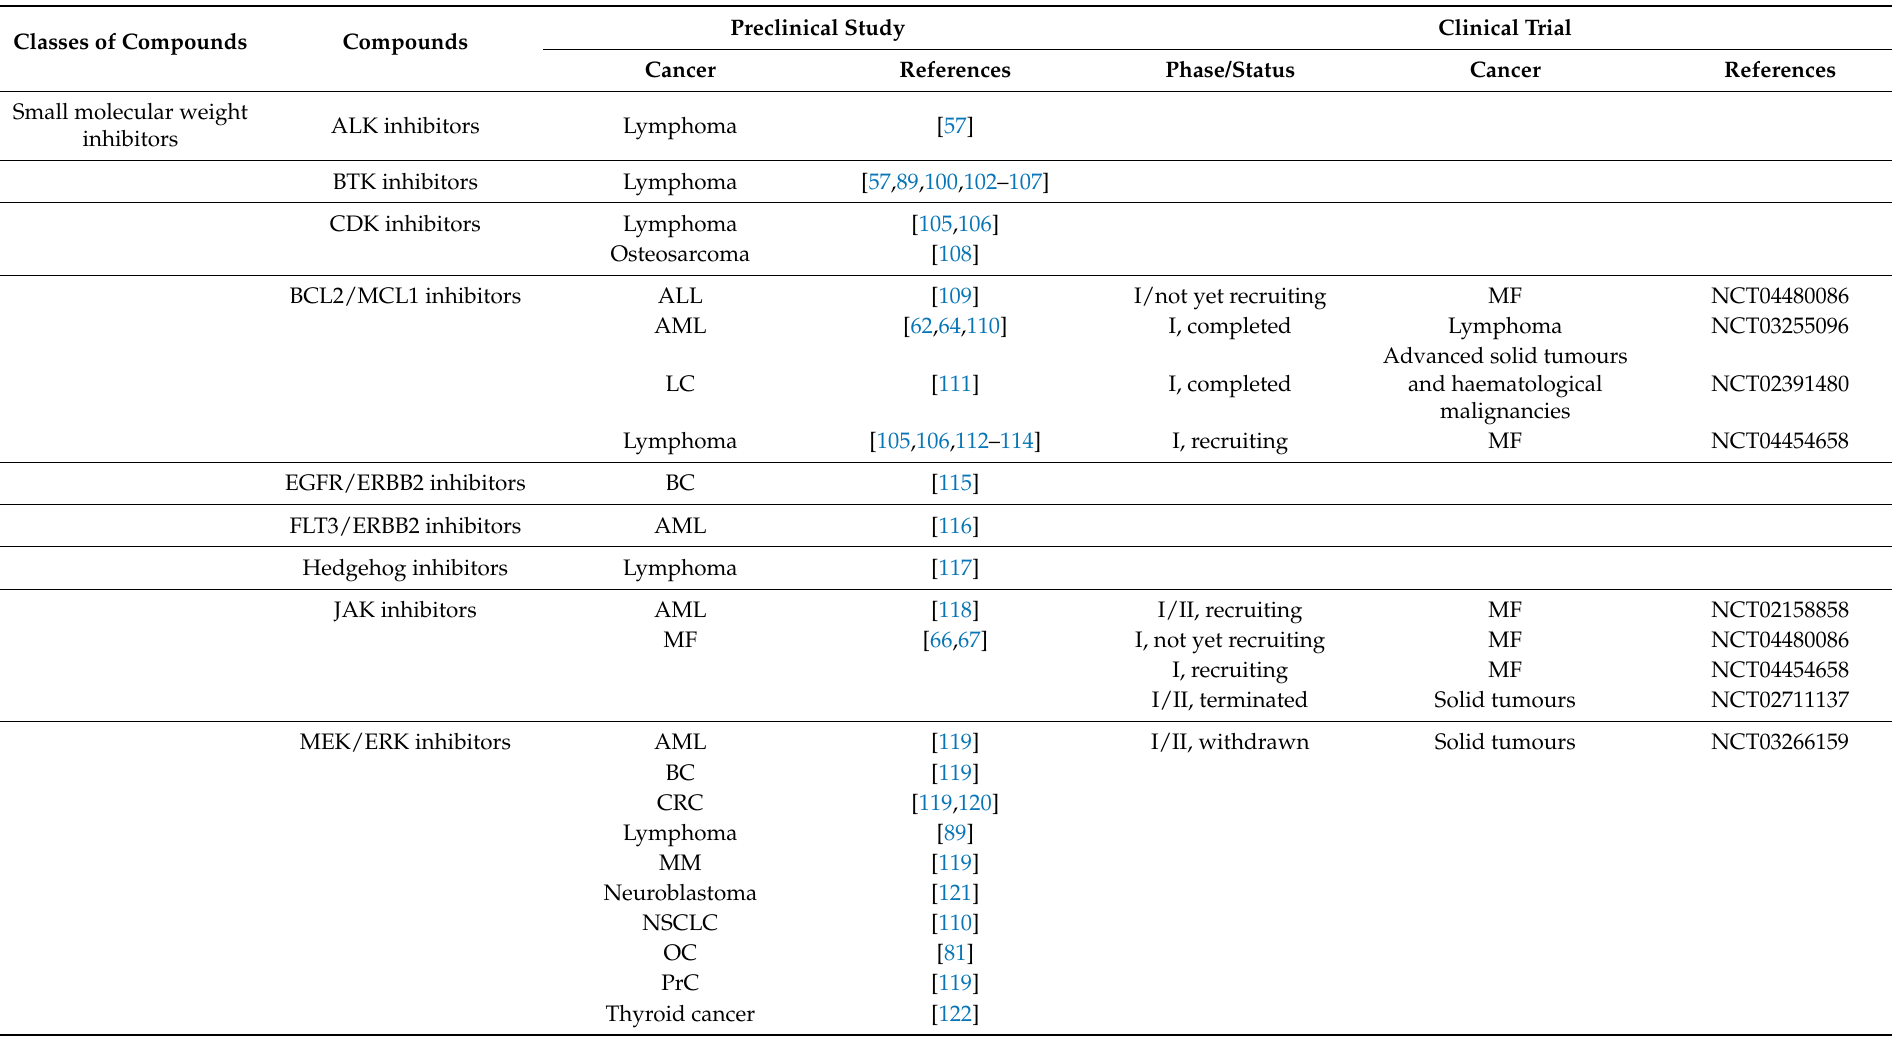
Table 2. Combinations of BET inhibitors with anticancer drugs in preclinical tumour models and clinical